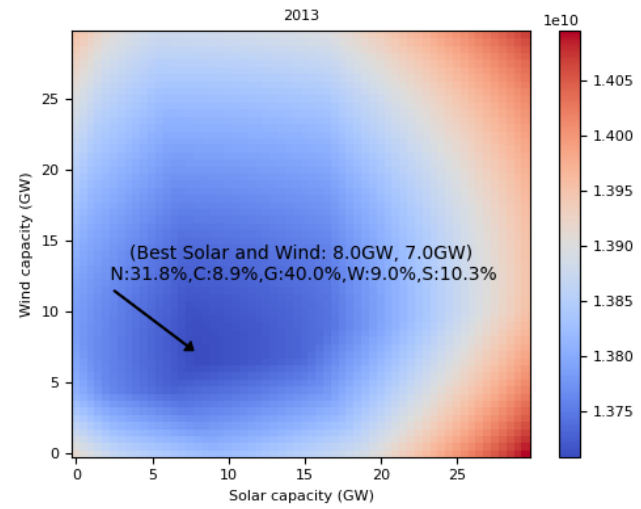
Figure 13. Heat map of cost estimate for year